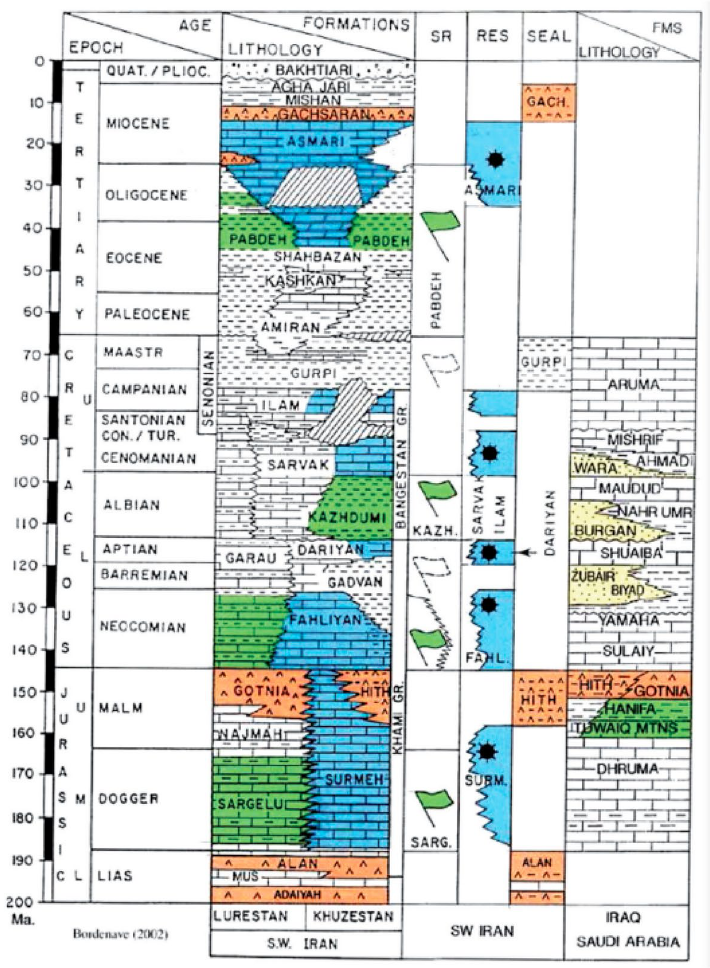
Fig. 2 Stratigraphic column of the studied area (Mohebian et al. 2013)